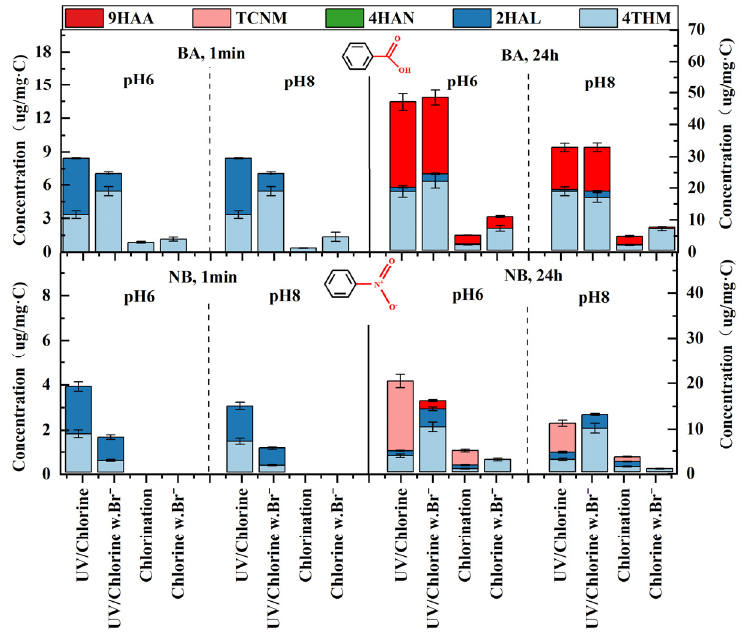
Figure 2. The formation of 4THM, 9HAA, 4HAN, 2HAL, and TCNM during the 1 min short-term oxidation and 24 h post-chlorination from two inert benzene derivatives. Short-term oxidation conditions: Chlorine dose = 10 mg chlorine/L, pH = 6.0 or 8.0, [model benzene precursors] 0 = 3 mg-C/L, UV fluence rate = 10 mW/cm 2 , [bromide] 0 = 1 mg/L. Post-chlorination conditions: pH = 8.0, chlorination time = 24 h, chlorine residual = 1.0 ± 0.4 mg/L, dark, 22 °C.